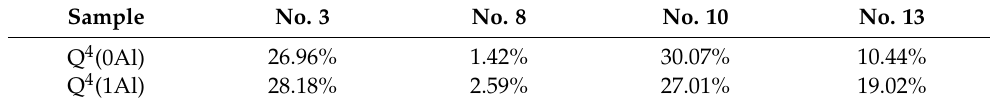
Table 3. Deconvolution results of 29 Si MAS NMR spectra of different